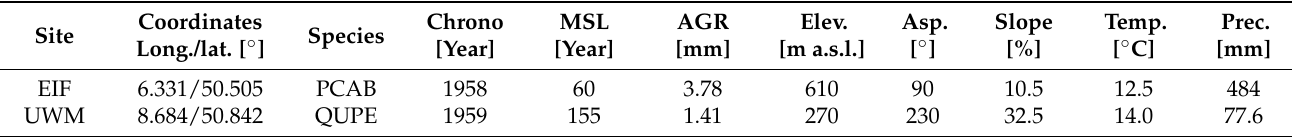
Table 1. Overview of the stand and site